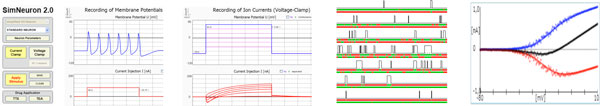
SimNeuron menu and recording examples from the current-clamp, whole-cell voltage-clamp lab, single channel patch-clamp lab (closed and open states with gating) with I-V curves for K+- (blue), Na+- (red) and unspecific cation (black) ion channels